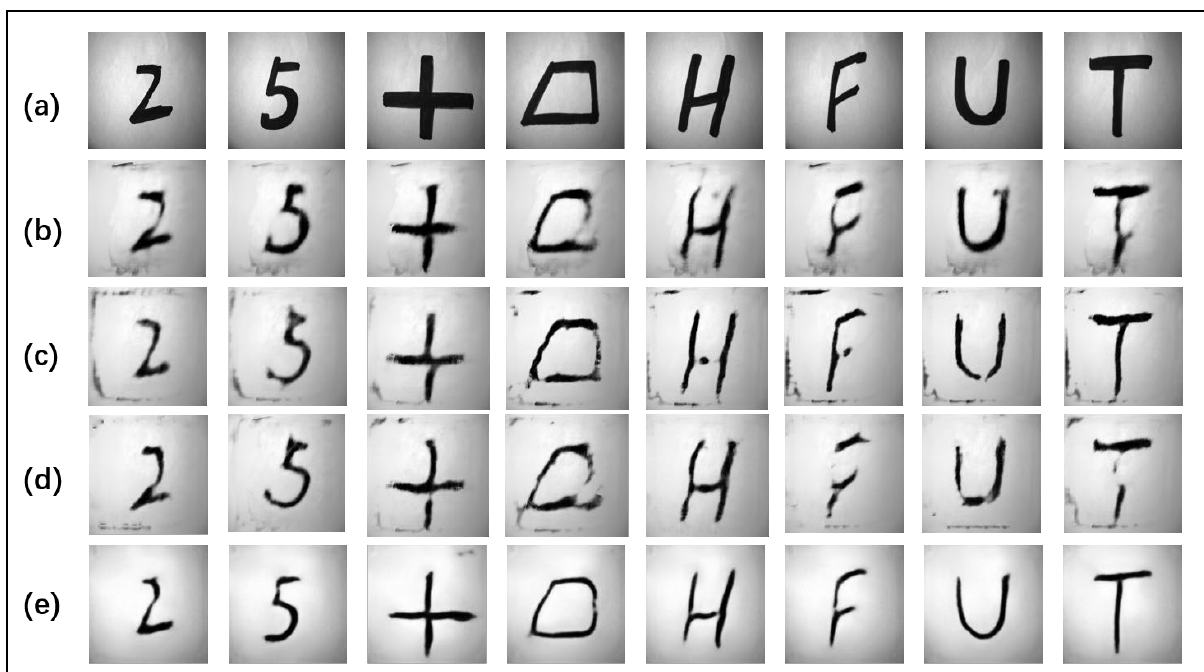
Figure 11. The comparison of Model-I, Model- I X , model-Q and Model-DoP. ( a ) Ground truth; ( b ) Model-I X ; ( c ) Model-I; ( d ) Model-Q; ( e ) Model-DoP.